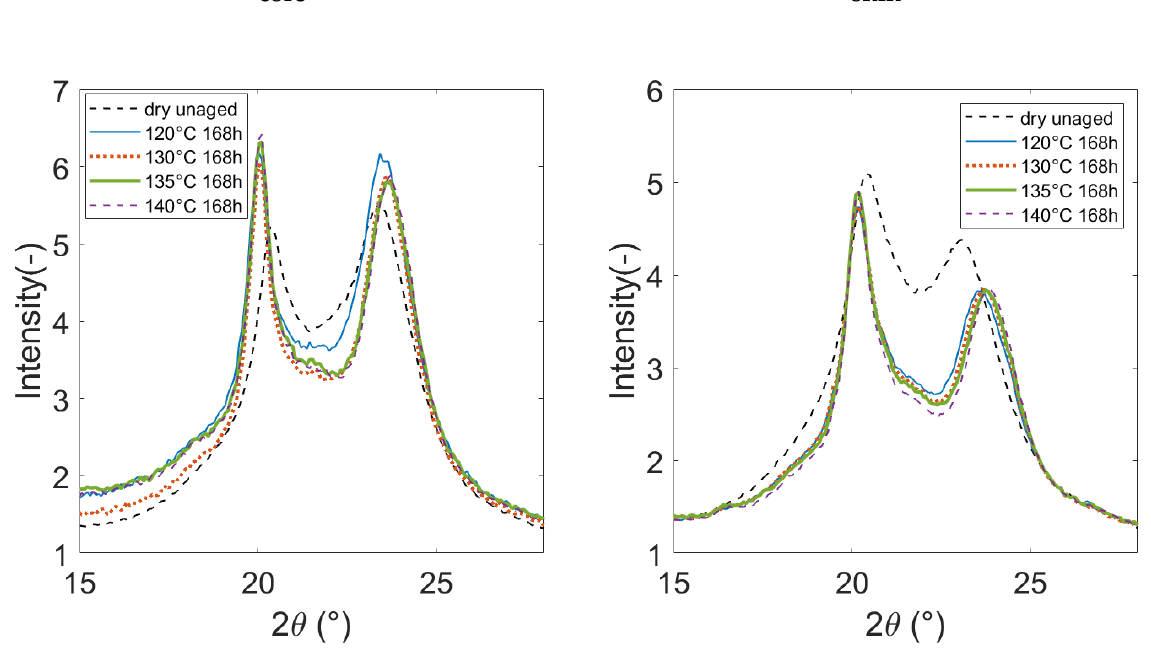
Figure 9. Typical diffractograms of unaged and aged PA66 during 168 h.